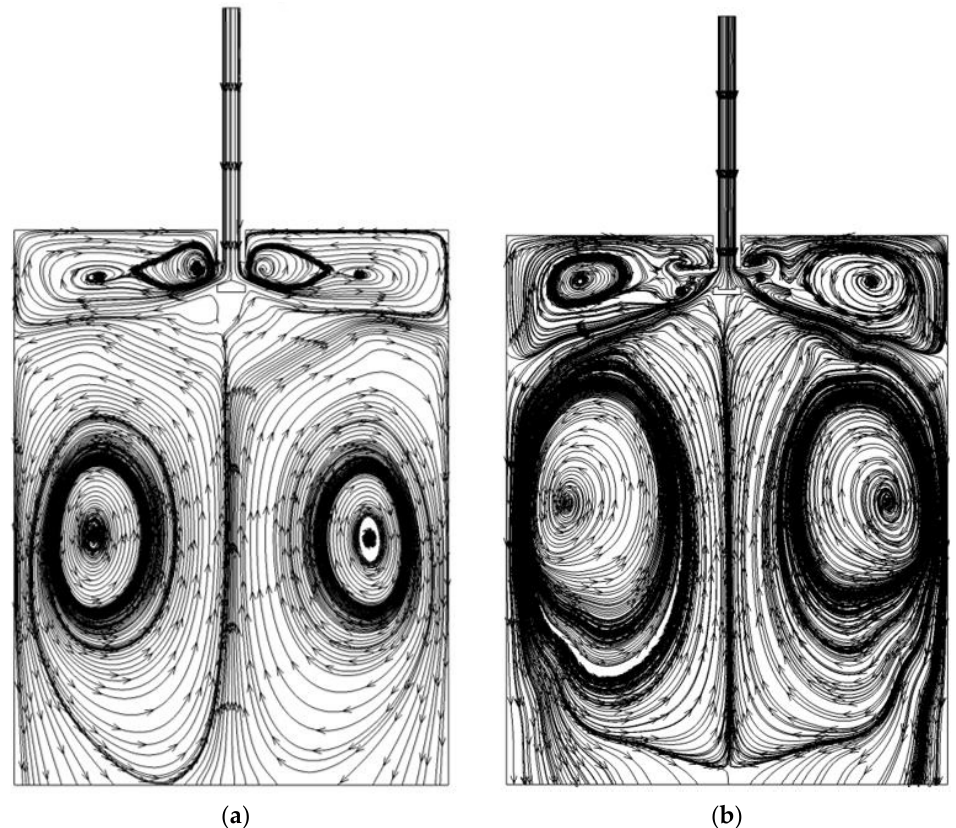
Figure 13. Streamlines on center plane of mold with the different SEN bottom shapes of ( a ) mountain, ( b ) well.